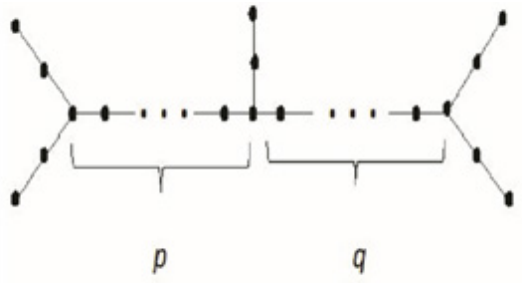
Figure 3: Maximal energy tree in Ω( n ,2).